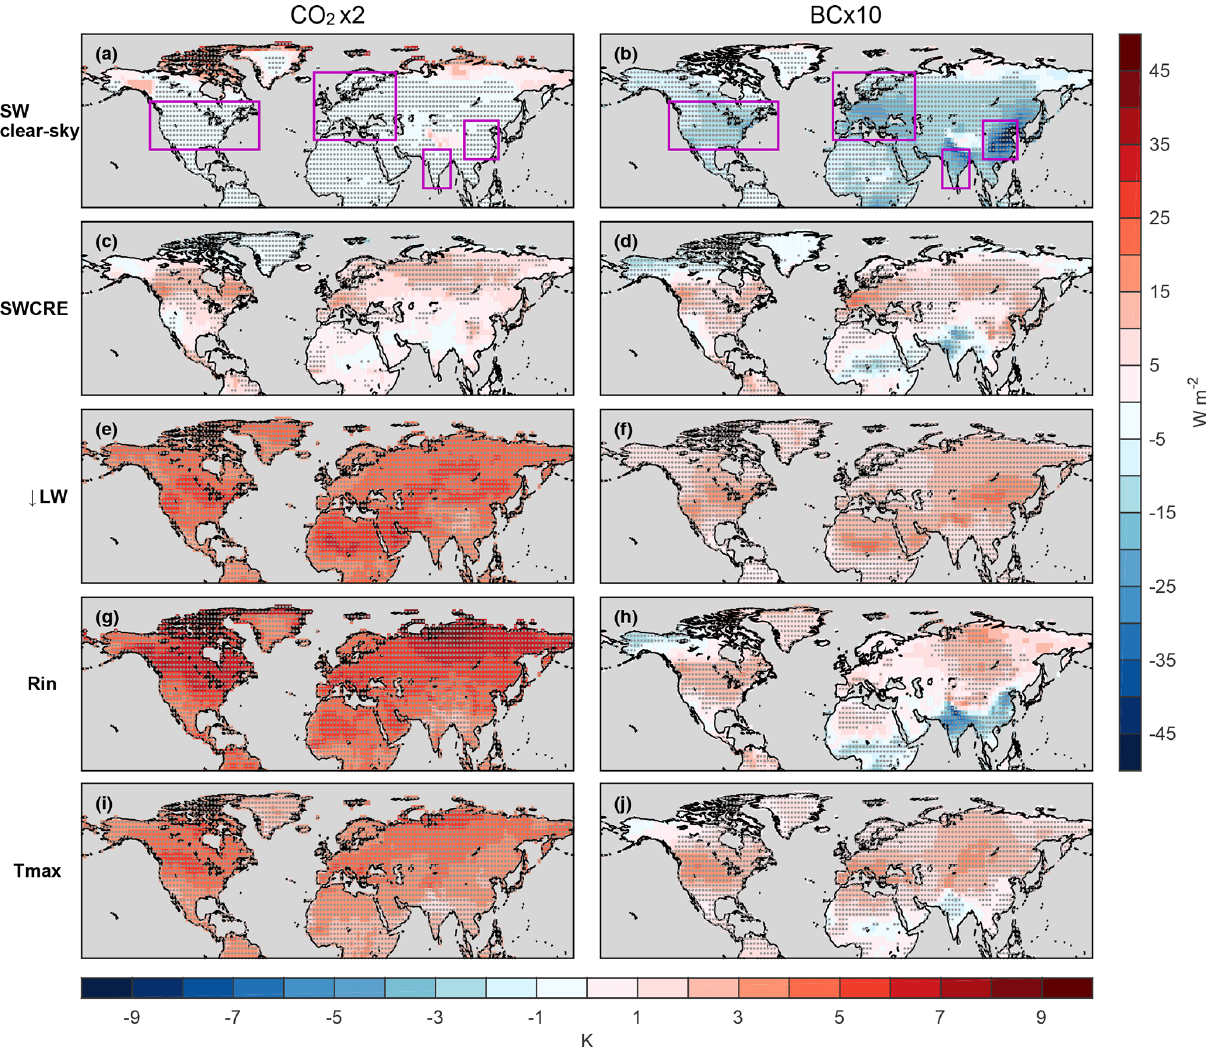
Figure 9. Changes in R in and its components (a–h) as well as changes in T max (i–j) for the CO 2 × 2 (a, c, e, g, i) and BC × 10 (b, d, f, h, j) experiments (original output, no normalization